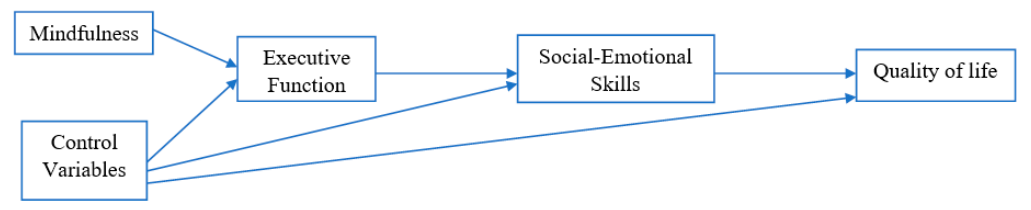
Figure 1. Hypothesized SEM Model.